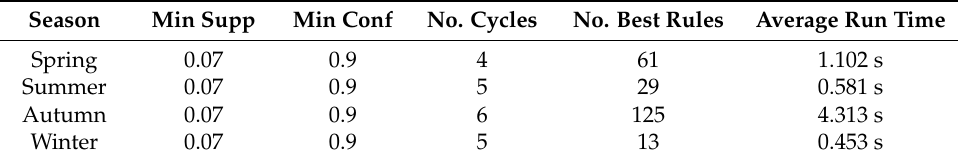
Table 2. Travel route recommendation performance evaluation in different seasons.